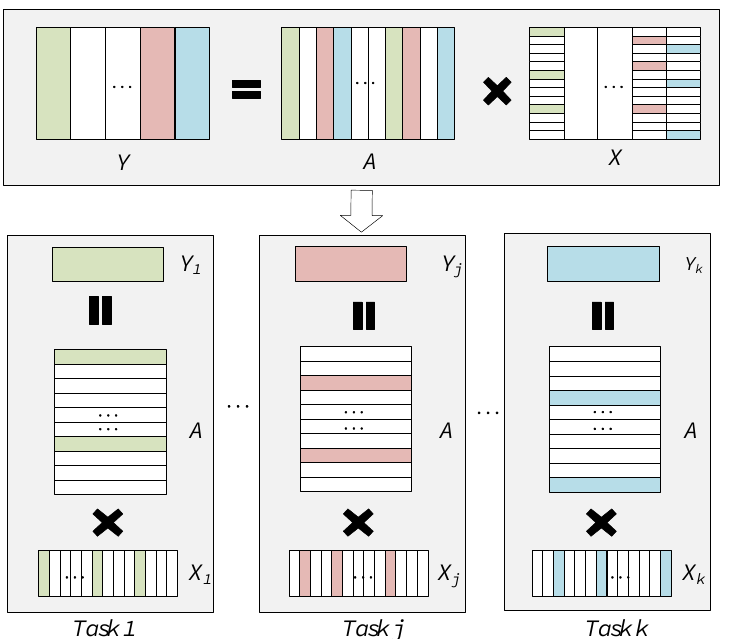
Figure 1. The evolutionary multitasking optimization framework for hyperspectral sparse